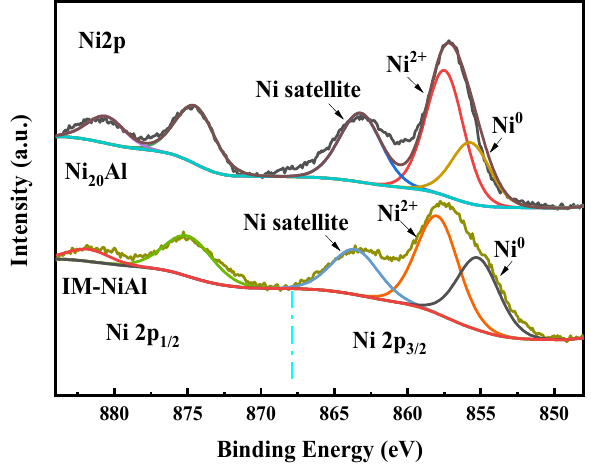
Figure 4. Ni XPS spectra of the reduced Ni 20 Al and IM-NiAl.